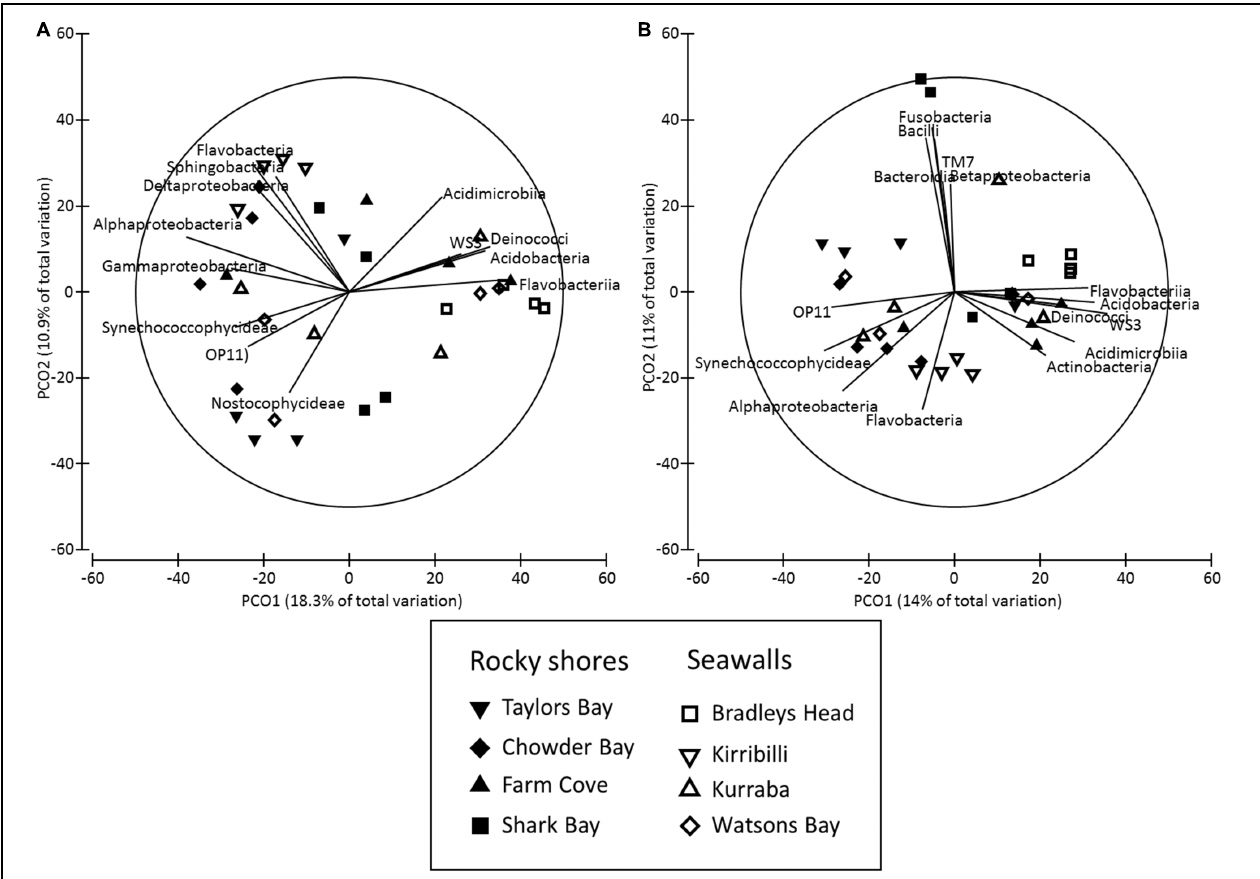
FIGURE 3 | Principal co-ordinates (PCO) analysis of bacterial community structure ((A) Bray–Curtis) and composition ((B) Jaccard) sampled from substrate experimentally deployed in natural rocky shores and artificial seawalls (Recruitment blocks). Vector plot of bacterial taxa (at level of class) most strongly related ( R > 0.5) to differences in community structures are also presented. Lengths of vectors indicate the strength and direction of relationships to measured